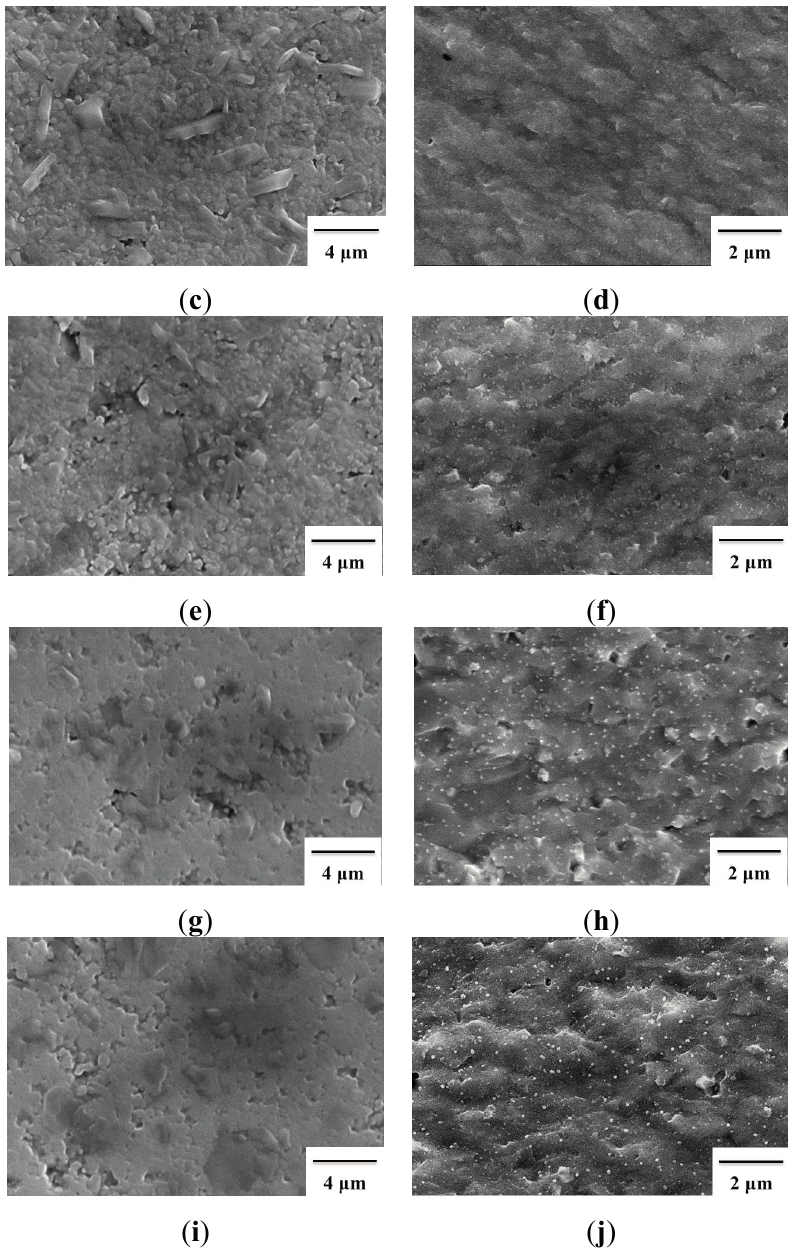
Figure 3. SEM micrographs of the sintered surfaces ( a ), ( c ), ( e ). ( g ), and ( i ) and the fractured surfaces ( b ), ( d ), ( f ), ( h ), and ( j ) of 0.9BaTiO 3 –0.1 (Bi 0.5 Na 0.5 )TiO 3 ceramic sintered at 1215 °C for 2 h. ( a ) and ( b ) are pure 0.9BaTiO 3 –0.1(Bi 0.5 Na 0.5 )TiO 3 ceramic; ( c ) and ( d ) correspond to the ceramic with 1.0 mol% Ta 2 O 5 ; ( e ) and ( f ) correspond to the ceramic with 2.0 mol% Ta 2 O 5 ; ( g ) and ( h ) correspond to the ceramic with 1.0 mol% Nb 2 O 5 ; and ( i ) and ( j ) correspond to the ceramic with 2.0 mol% Nb 2 O 5 . Figures 4 and 5 show the TCCs and dielectric losses versus temperature, measured at a frequency of 1 kHz, of 0.9BaTiO 3 –0.1(Bi 0.5 Na 0.5 )TiO 3 ceramics with various amounts of added Ta 2 O 5 and Nb 2 O 5 sintered at 1215 °C, respectively. Some of the dielectric properties, including the Curie point, dielectric constant, and tan δ value at 25 °C and TCCs at both 25 °C and 200 °C, are also listed in Table 2. The temperature dependence of the 0.9BaTiO 3 –0.1(Bi 0.5 Na 0.5 )TiO 3 ceramics became flattened